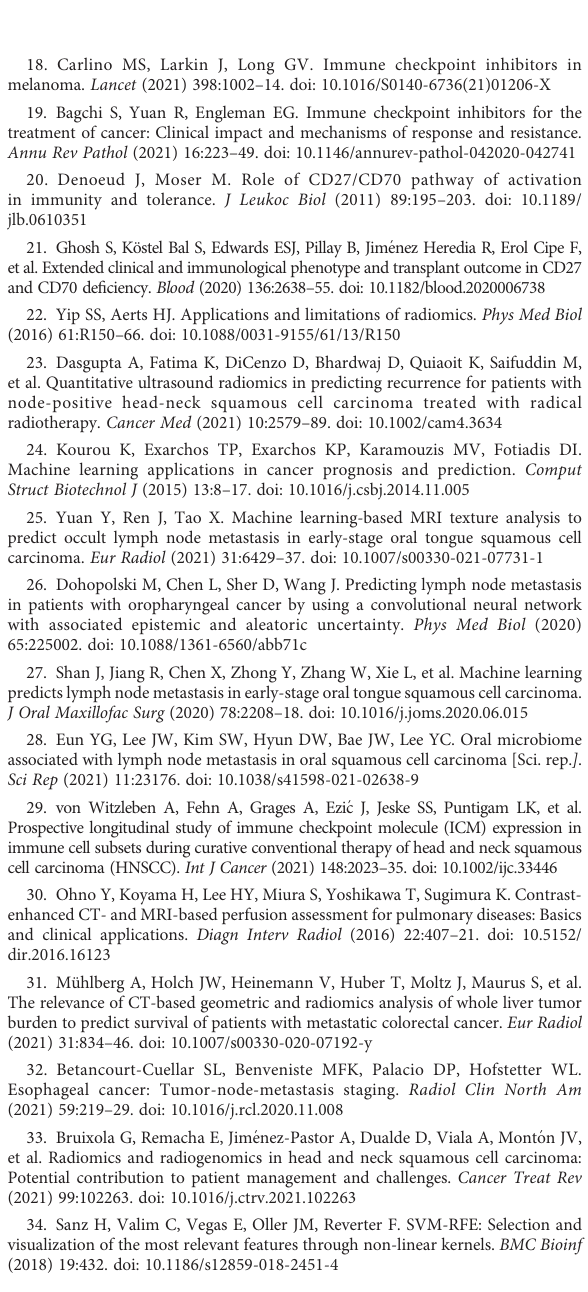
SUPPLEMENTARY FIGURE 1 Correlations between the T (A) and N (B) stages, perineural invasion (C) , radiotherapy (D) , and OS in